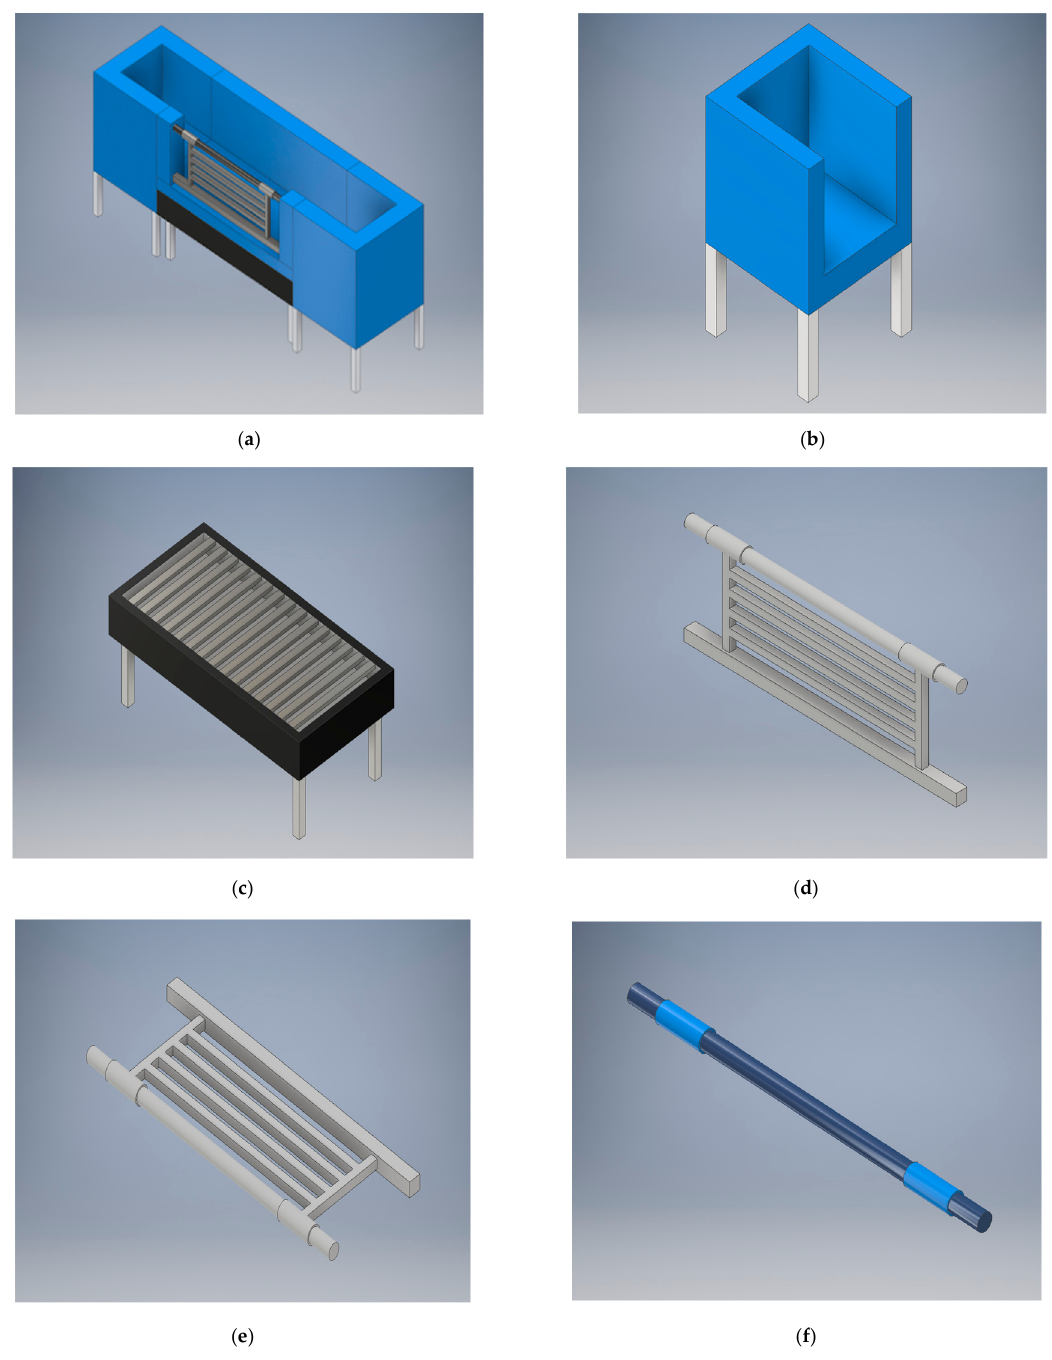
( e ) Figure 3. Repurposed parts of concept 2. ( a ) Crib design. ( b ) Grill design. ( c ) Safety door design. ( d ) Dying rack design. ( e ) Pull-up bar design. Concept 3: This concept includes ideas from concepts 1 and 2. It also includes a crib, as shown in Figure 4a. Once the child has outgrown the crib, the sides of the crib can be